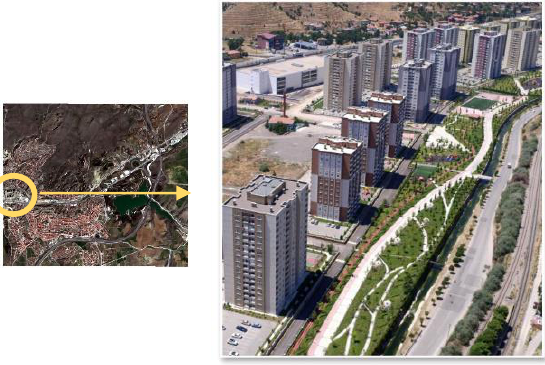
Figure 17. A part of urban transformation project within the study